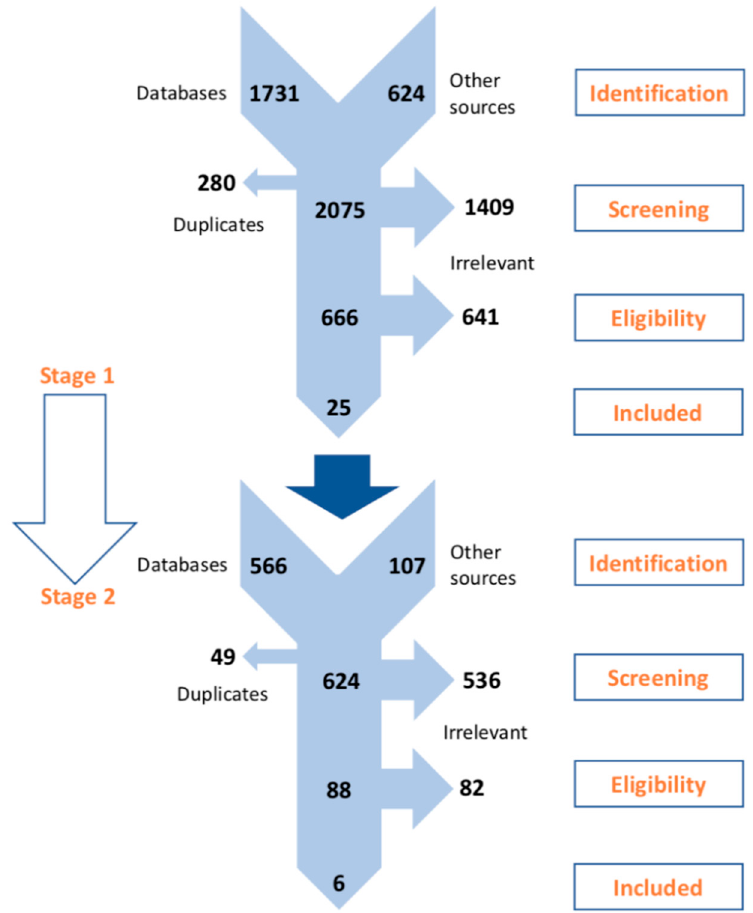
Figure 1. PRISMA flowchart presenting the selection process at the two stages. PRISMA, Preferred Reporting Items for Systematic Reviews and Meta-Analyses.